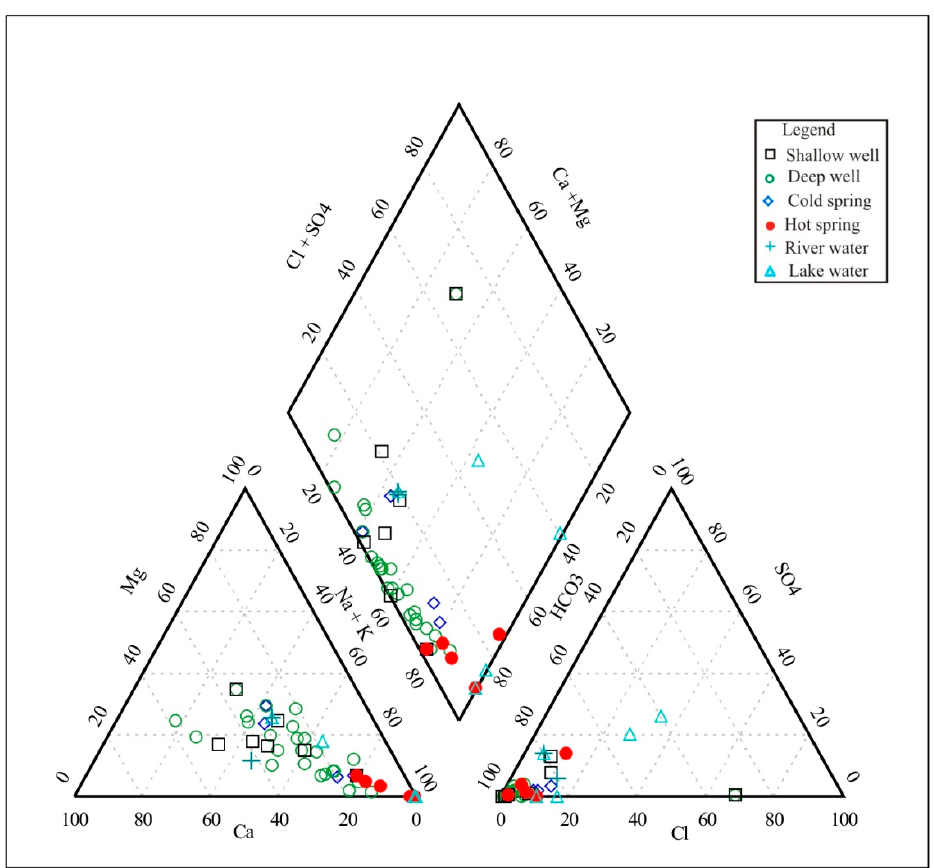
Figure 3. Piper diagram showing the hydrochemical facies of groundwater and surface water in the Bilate river basin.